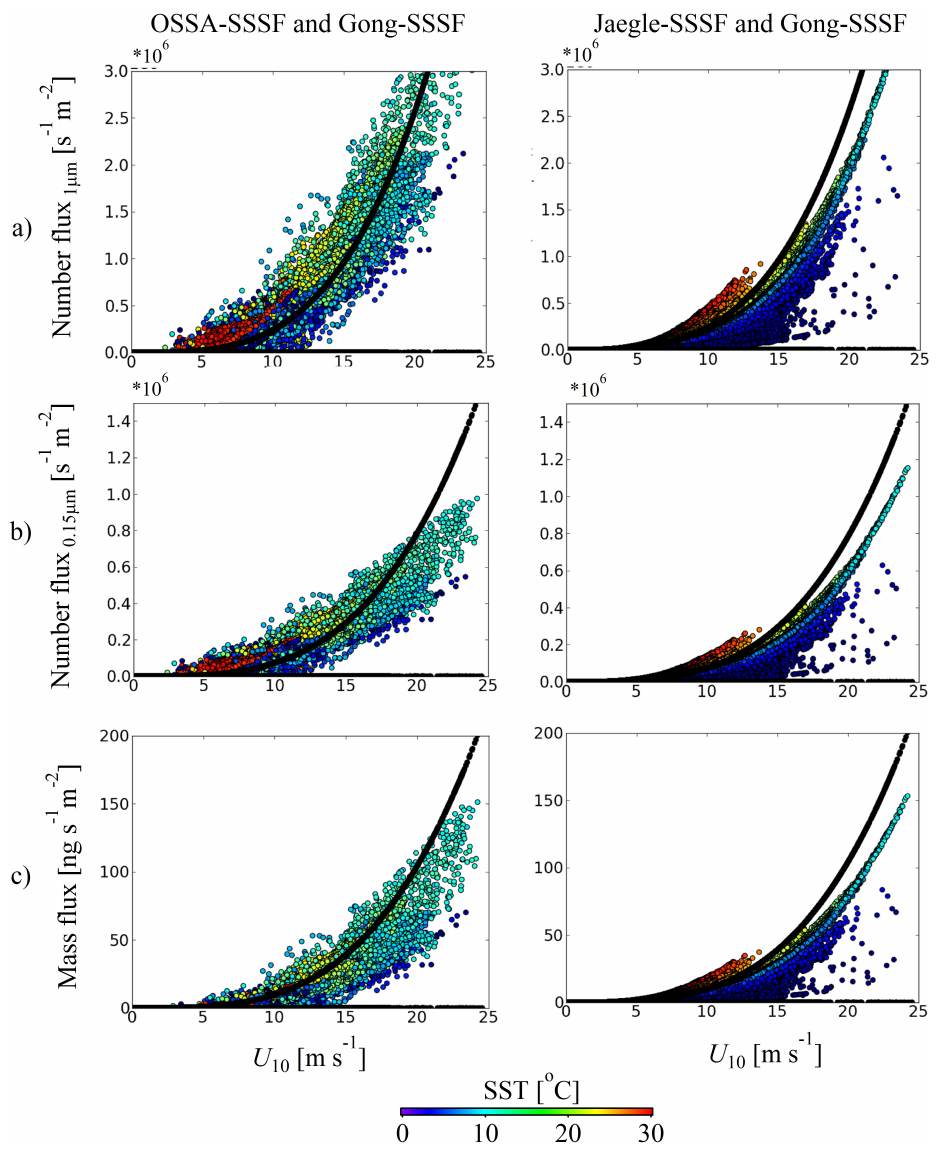
Fig. 11. Global instantaneous (2 January 2006, 00:00UTC) SSA number and mass fluxes; Left panel: computed using the OSSA-SSSF (colour circles) overlapped with black dots representing fluxes computed using the Gong (2003) SSSF; Right panel: computed using the Jaeglé et al. (2011) SSSF (colour circles) overlapped with black dots representing fluxes computed using the Gong (2003) SSSF; Colours represent SST; (a) number flux for particles 0.07< D <1µm; (b) number flux for particles 0.07< D <0.15µm; (c) mass flux for particles 0.07<D